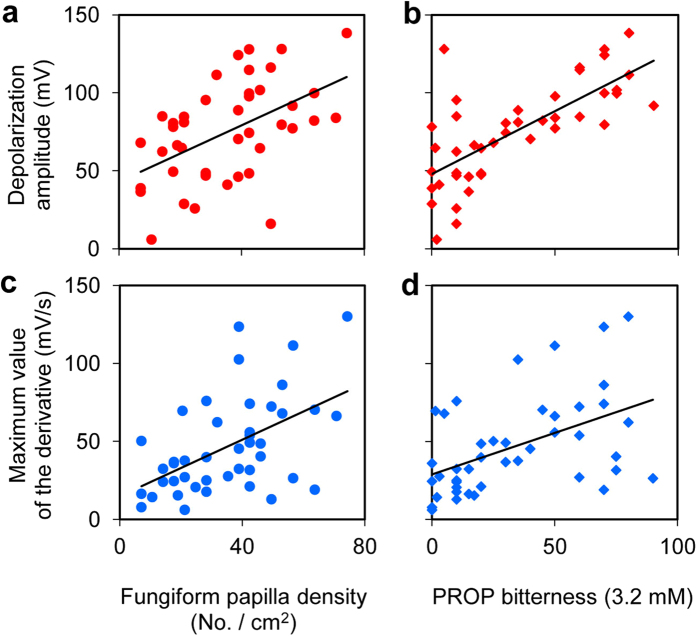
Linear correlation analysis between the parameters describing the waveform of signals and those defining PROP taste sensitivity.(a) Relationship between depolarization amplitude and density of fungiform papillae (r = 0.504; P = 0.00057). (b) Relationship between depolarization amplitude and intensity of perceived PROP bitterness (r = 0.741; P < 0.00001). (c) Relationship between the maximum value of the first derivative and density of fungiform papillae (r = 0.518; P = 0.00037). (d) Relationship between the maximum value of the first derivative and intensity of perceived PROP bitterness (r = 0.511; P = 0.00053). n = 43 participants.